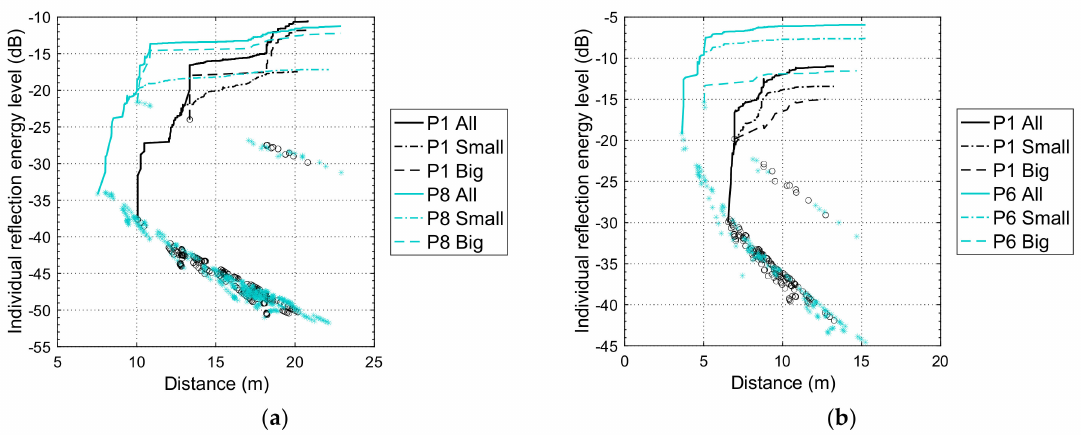
Figure 8. Retroreflected octave-band energy levels (4 kHz octave band) returned to the source position of individual equivalent reflectors: ( a ) Panna Meena ka Kund (full model); ( b ) Lahan Vav. Markers show the individual reflection values; lines show the cumulative complex sum of reflections as a function of distance. Values are expressed relative to the emitted free field energy at 1 m. Note that all markers for Panna Meena ka Kund P1 are superimposed pairs from